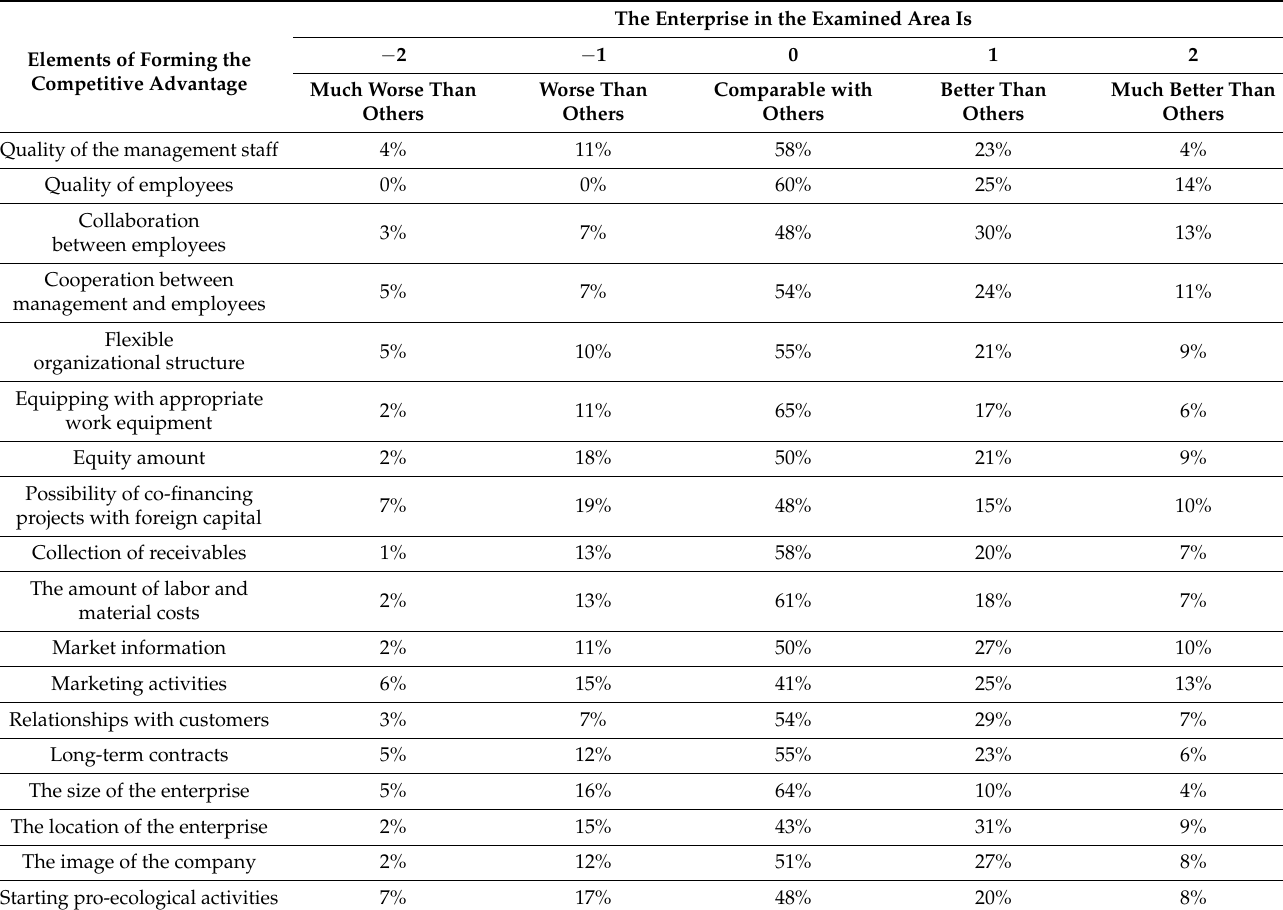
Table 4. Assessment of the competitive positions of enterprises according to the elements shaping their competitive